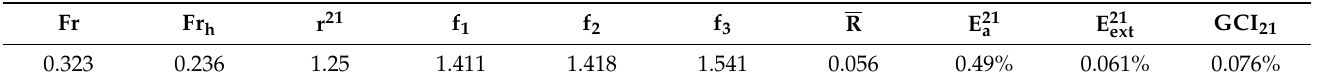
Table 7. Results of the mesh convergence study for the catamaran in deep